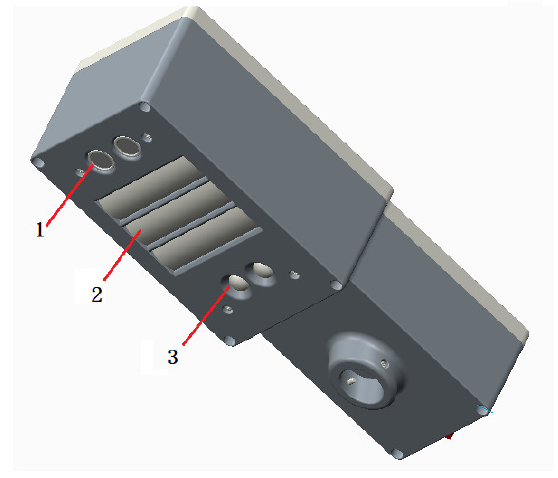
Figure 7. Self-developed dual-band reflectance spectrometer. (1) Ultrasound ranging sensor, (2) narrow band active light source, (3) reflected light detector.